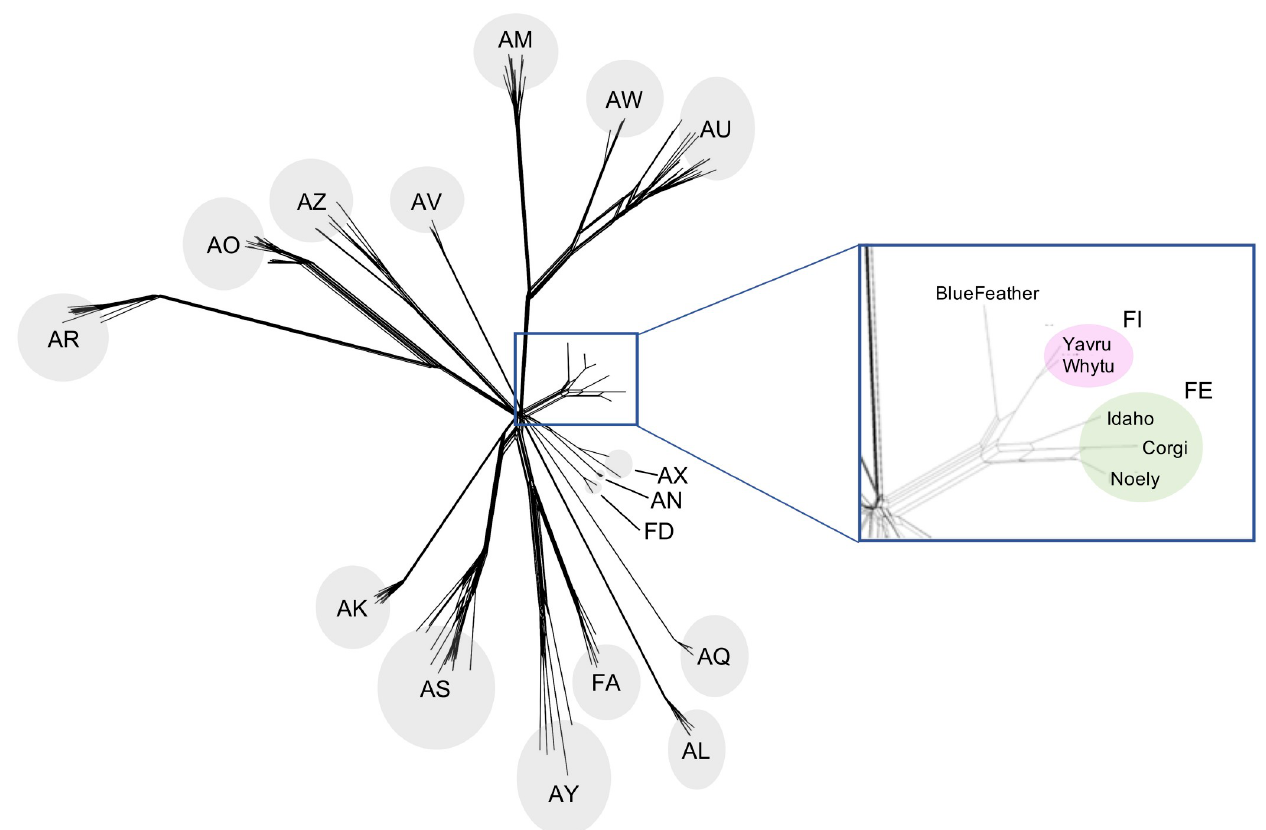
Fig 5. Expanded Cluster FE includes BlueFeather and former FI phages. A SplitsTree was generated in order to group Arthrobacter phages based on pham similarity. Ten representative phages from each cluster were selected to measure evolutionary relatedness. While there is great diversity of Arthrobacter phages, BlueFeather forms a relatively small branch with phages originally assigned to Cluster FE and the former Cluster FI. These phages, boxed in blue, comprise the expanded FE Cluster.